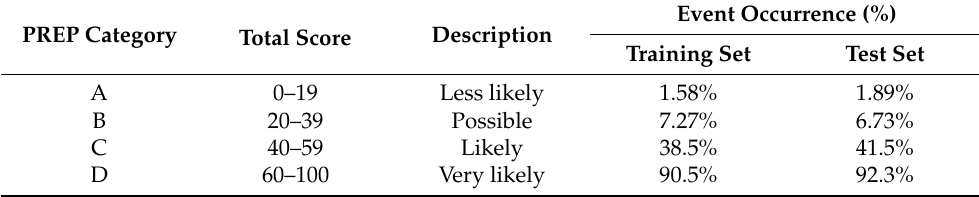
Table 4. Risk categories according to the risk